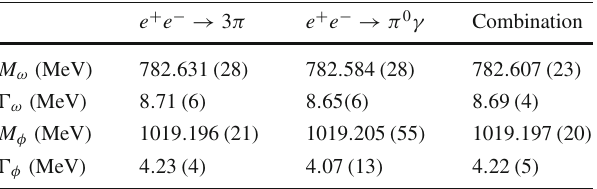
Table 5 ω and φ resonance parameters from e + e − → 3 π [13], e + e − → π 0 γ (this work), and their combination. The final uncer- tainties for M ω and (cid:11) φ include a scale factor S = 1 . 2. All